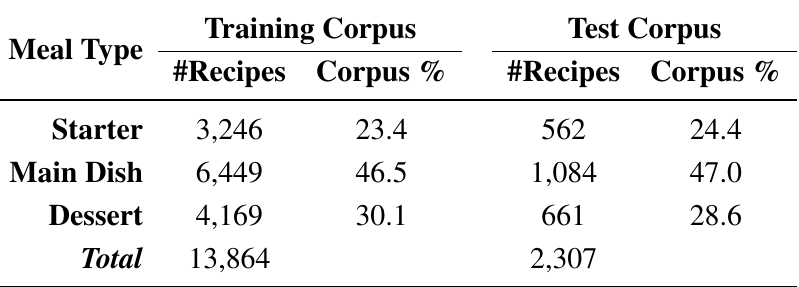
Table 2. Corpus: distribution of recipes by type of